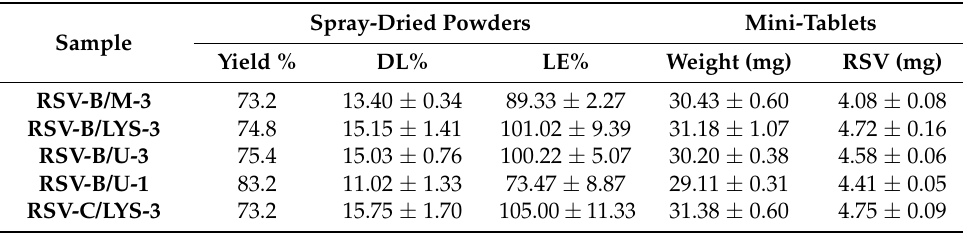
Table 7. Characterization of the CPE-loaded spray dried powders (yield %, DL% and LE% ± SE) and the resulting sublingual mini-tablets (weight and drug content ± SE; n =